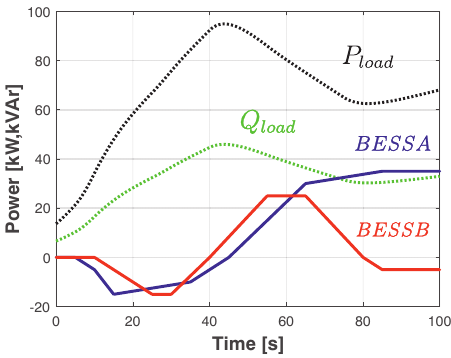
Figure 5. BESS A active power (blue line), BESS B active power (red line), sum of load active power (dotted black line), sum of load reactive power (dotted green line).